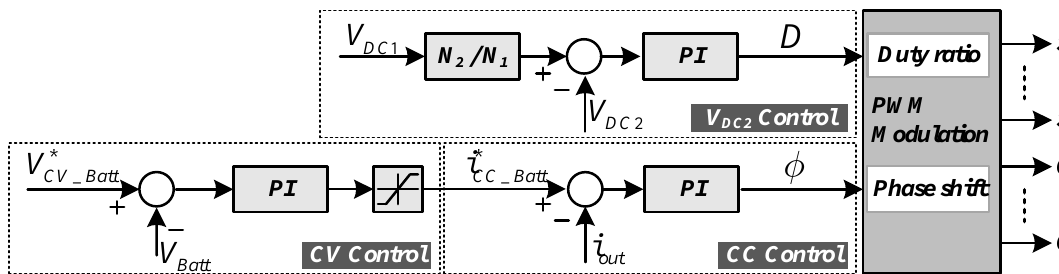
Figure 11. The proposed control block diagram of 3P-CFDAB converter.